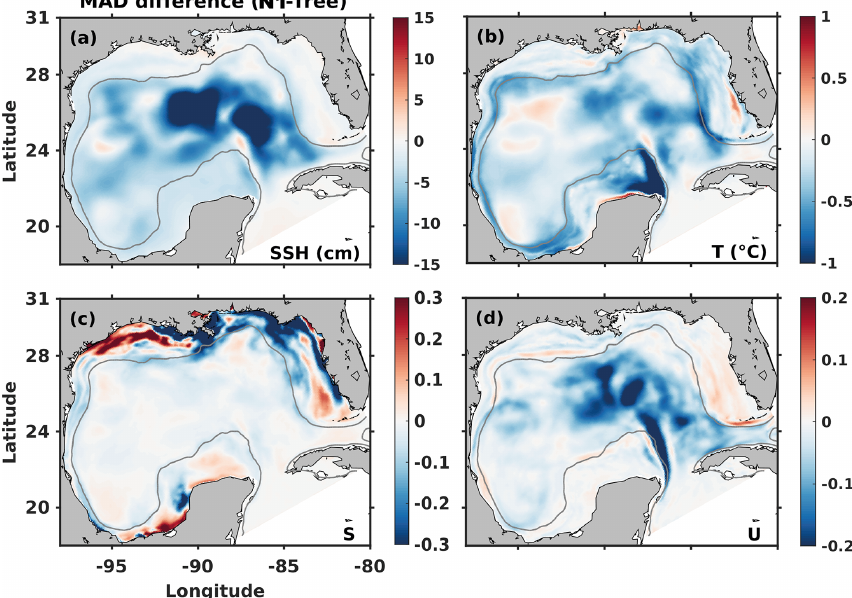
Figure 5. The difference in physical variable time-averaged (daily snapshots from 1 April to 1 October) MAD between nonidentical twin N1 and the free run. MADs of temperature and velocity were averaged over the entire water column. Negative values (cold colors) correspond to a decrease in MAD compared to the free run, whereas positive values (warm colors) correspond to an increase. The gray contour marks the bathymetric depth of 300m.